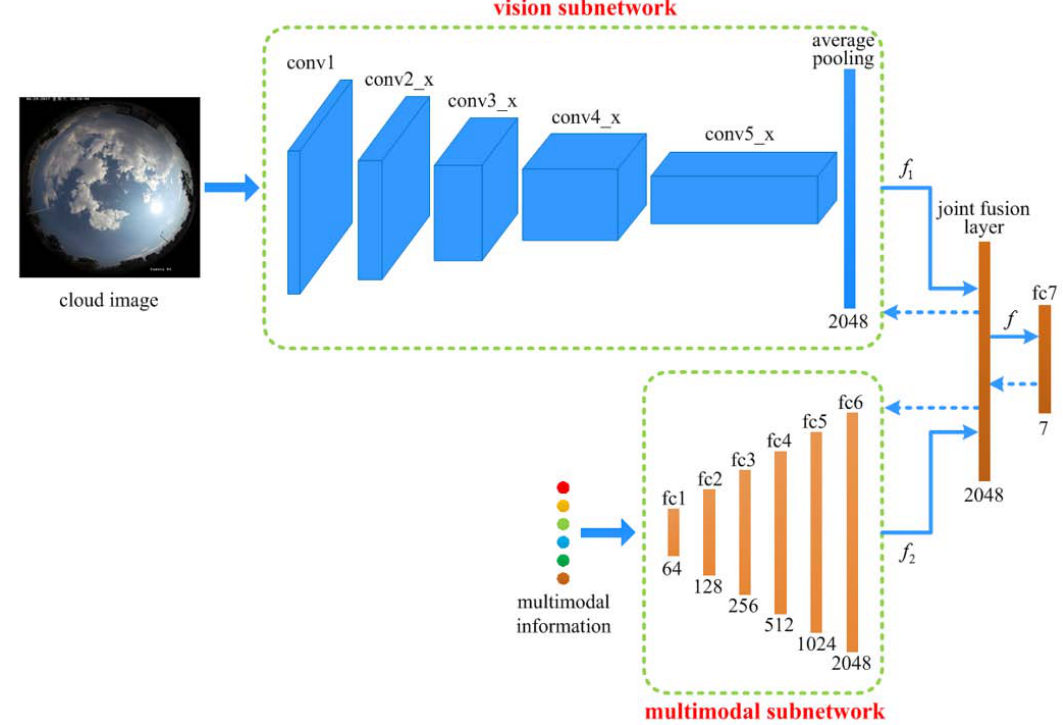
Figure 2. Architecture of the proposed JFCNN. In the multimodal subnetwork, the number below each layer denotes the number of neurons. The blue solid and dashed lines denote the forward and back propagation processes, respectively. Table 1. Architecture of the ResNet-50. Herein, “stride 2” denotes the filter slides with the step of two